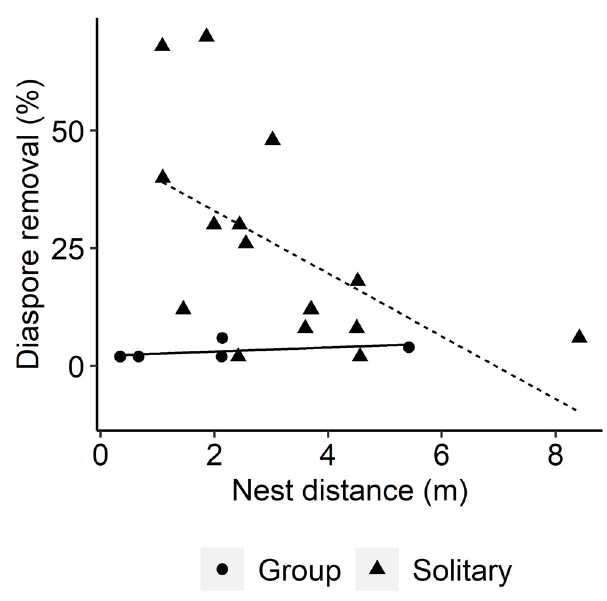
Fig 5 . Ants with solitarily removal and ants with nests less distance ( x -axis) remove more diaspores ( y -axis). The number of diaspores removed is expressed as a percentage (number of diaspores removed by the species/total diaspores available at the sampling point*100). The circles and the line indicate group removal ants, and the triangles and dashed line indicate solitary remover